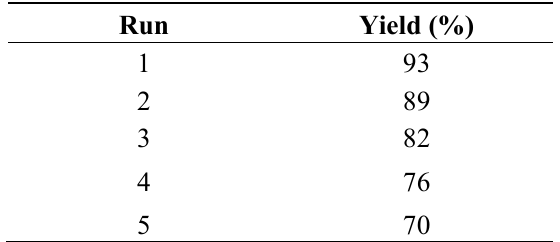
Table 2. Recycling and reuse of PEG-400-H